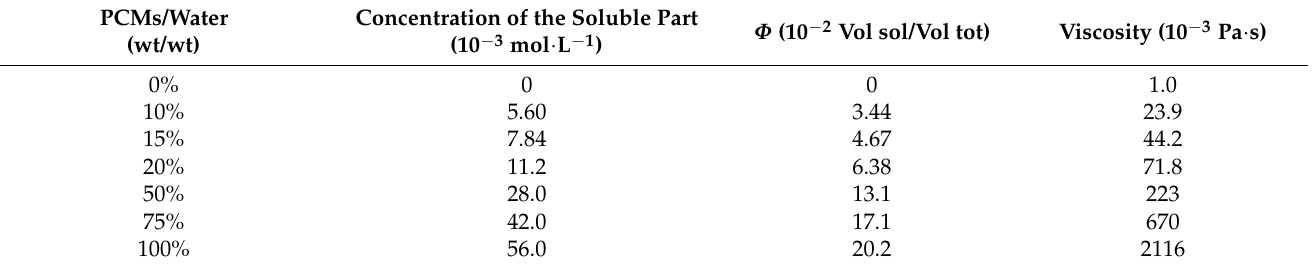
Table 4. Viscosity of s/s PCMs in water